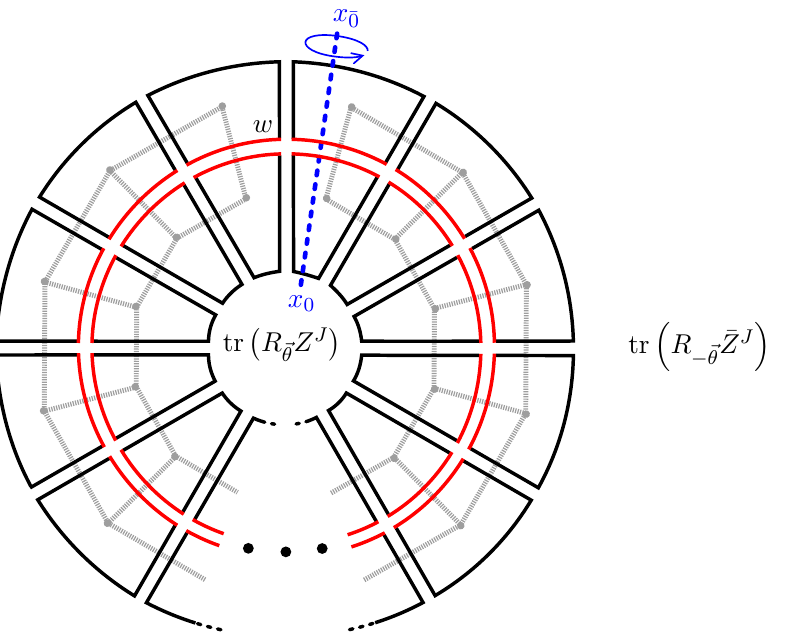
Figure 18 . The (cid:12)rst loop correction to the two-point function hO J (cid:22) O J i in (6.1) comes from the dia- gram in the (cid:12)gure. It is composed of one wheel of the X scalar (in red) crossing all the Z -propagators (in black). After factoring out one of the loop integrations over an internal vertex ( w in the (cid:12)gure), we remain with a known ladder integral (dashed grey) times two propagators (between w and x 0 , x (cid:22)0 ). In appendix E, we use this representation of the integral to extract the J -loop anomalous dimension of these operators